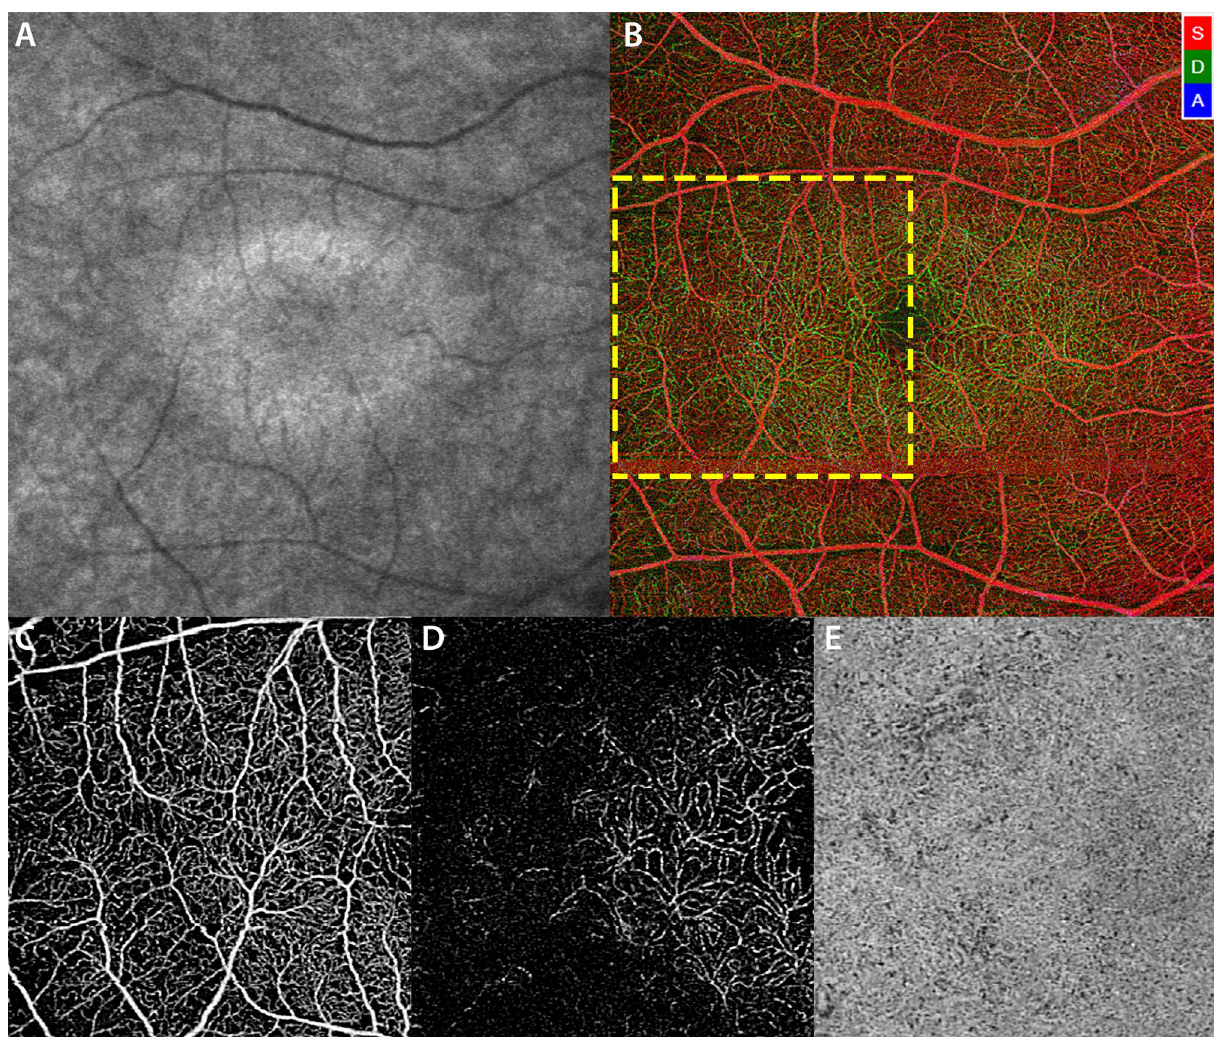
Figure 5. Patient affected by USH2A -related Retinitis Pigmentosa. The near-infrared fundus autofluorescence (NIR-FAF, A ) shows a central area of preserved autofluorescence (APA) which, on optical coherence tomography angiography (OCTA), corresponds to an area where the retinal vasculature looks intact ( B , color-coded map: red for superficial capillaries and green for deep capillaries). A 3 × 3 mm OCTA acquisition was taken on the edge of the APA (yellow box in B ), to better show the vascular alterations in the immediate surroundings of the APA, at the level of the superficial vascular complex (SVC, C ), the deep capillary plexus (DCC, D ) and the choriocapillaris (CC, E ). Outside the APA there is a mild capillary drop out in the SVC ( C ), while the DCC is completely depleted ( D ). Flow deficits in the CC are larger and more numerous outside the APA ( E